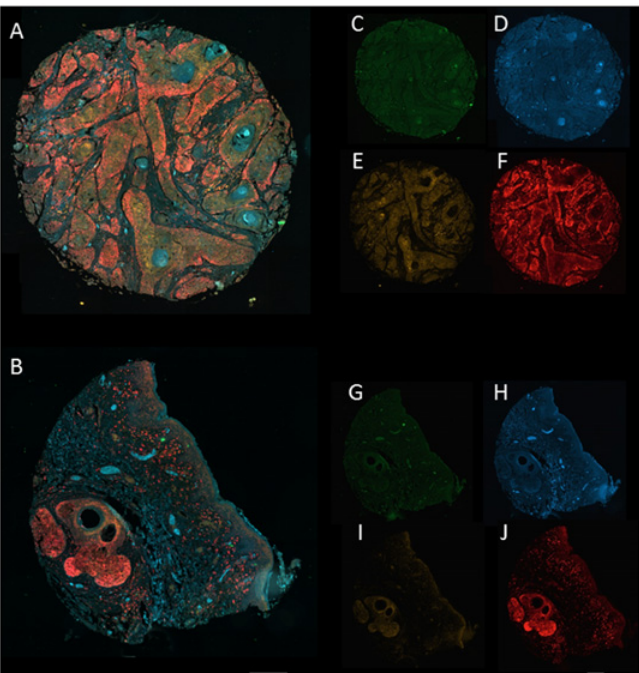
Fig 1. Representative images from Zeiss AxioScan Z1 slide scanner. Composite, overlay, of four fluorophores (FITC, Alexa Fluor-405, Cy3 and Cy5 for MMP7, Wnt4, CD1 and c-MYC, respectively) in (A) PeCa tissue cores (core B2 of PE241) and (B) control (core D5 of PE241, see methods). C-F are individual images used to construct the composite of PeCa tissue core, for MMP7 (C, green), Wnt4 (D, blue), CD1 (E, orange) and c-MYC (F, red). G-J are individual images used to construct the composite of control tissue core, for MMP7 (G, green), Wnt4 (H, blue), CD1 (I, orange) and c-MYC (J, red). Quantitative analysis was performed on the non-enhanced, original, gray images for which all settings were identical in all tissue core images analyzed. Scale bar = 250 μ m.